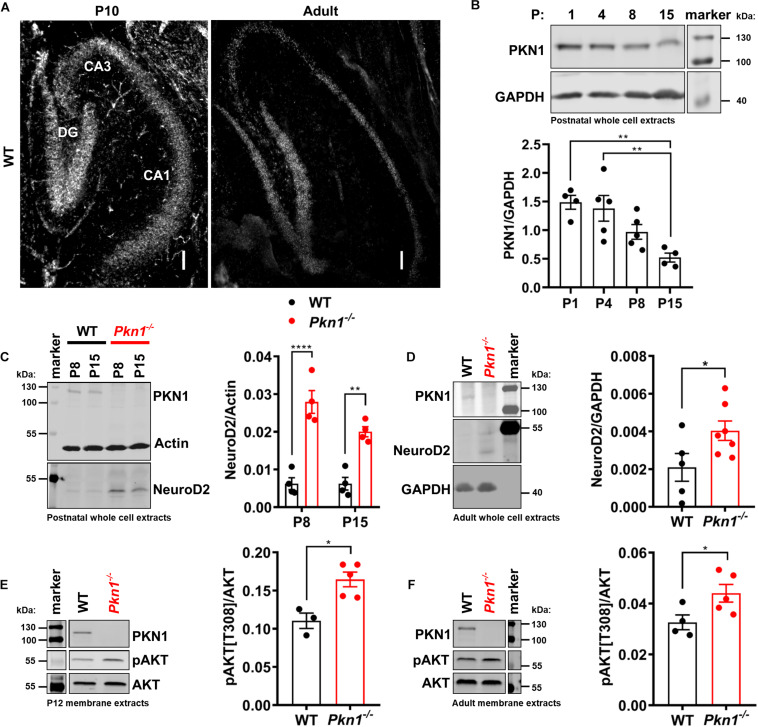
PKN1 regulates AKT phosphorylation and NeuroD2 levels in postnatal and adult hippocampi. (A) P10 and adult hippocampal sections from WT animals were tested for PKN1 expression by in situ hybridization. Pictures are representative of 2–3 separate WT animals. Scale bar refers to 100 μm. (B) PKN1 expression levels from P1 to P15 old WT hippocampi were assessed by western blotting (**P < 0.01, one way ANOVA with Tukey’s multiple comparisons test). (C) NeuroD2 expression in hippocampal whole cell protein extracts of P8 and P15 old WT and Pkn1–/– animals was assessed by western blotting (two way ANOVA: Interaction: P = 0.0745, Age: P = 0.0747, Genotype: P < 0.0001, Sidak’s multiple comparisons test: P8: P < 0.0001, P15: P = 0.0025). (D) NeuroD2 expression in adult WT and Pkn1–/– hippocampal whole cells extracts (*P = 0.0496, unpaired t-test). (E) Hippocampi from P12 old WT and Pkn1–/– animals were separated into cytosolic and membrane fractions. Membrane extracts were probed for phosphorylated AKT[T308] (pAKT[T308]) and total AKT and the ratio was calculated (*P = 0.0104, unpaired t-test). (F) Membrane fractions of adult WT and Pkn1–/– animals were probed for pAKT[T308] and AKT (*P = 0.045, unpaired t-test). The markers in the representative blots in (E,F) are shown in separate lanes as samples were not directly next to the markers in the blots. Data is presented as individual n-values with mean ± S.E.M.